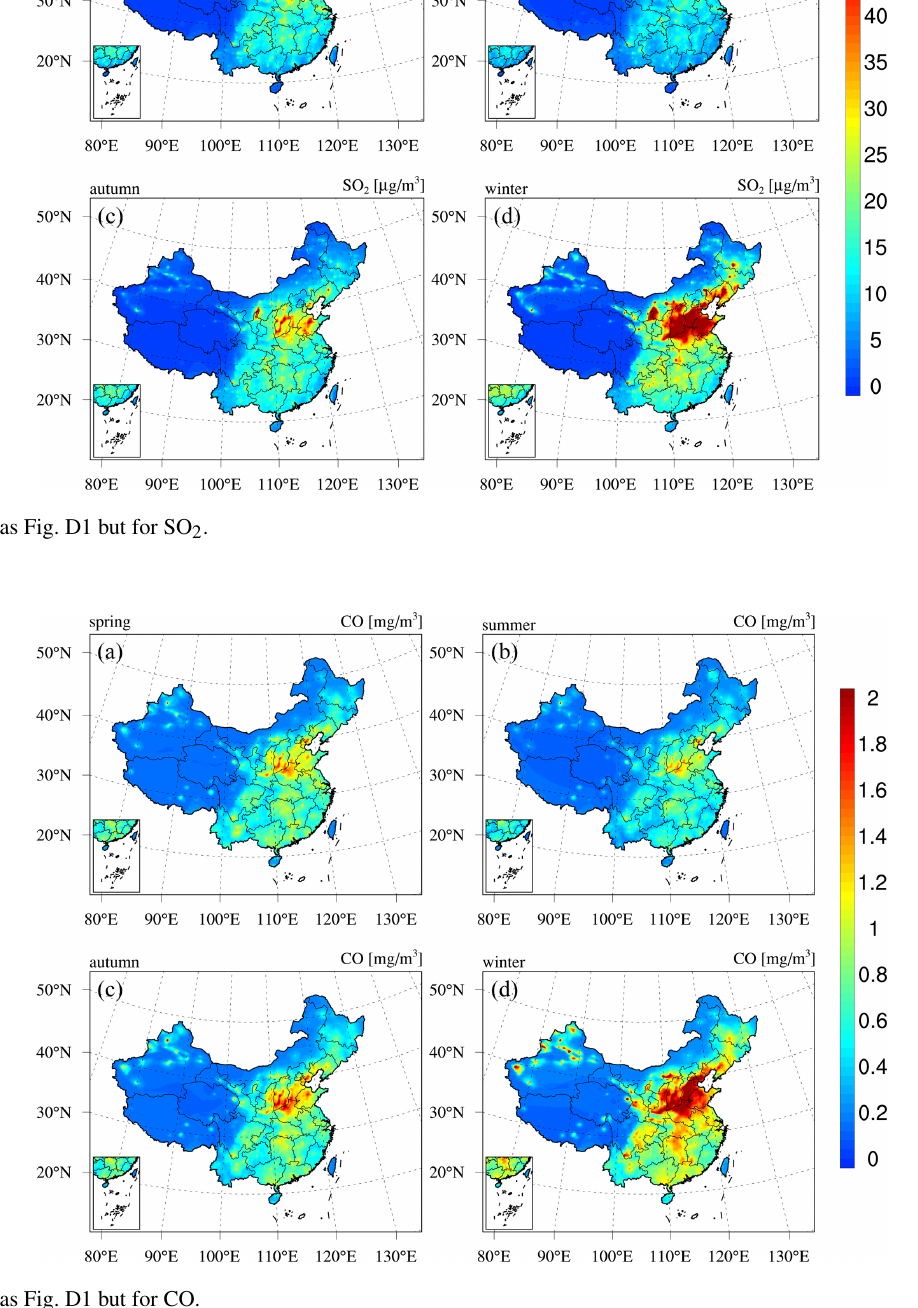
Earth Syst. Sci. Data, 13, 529–570, 2021